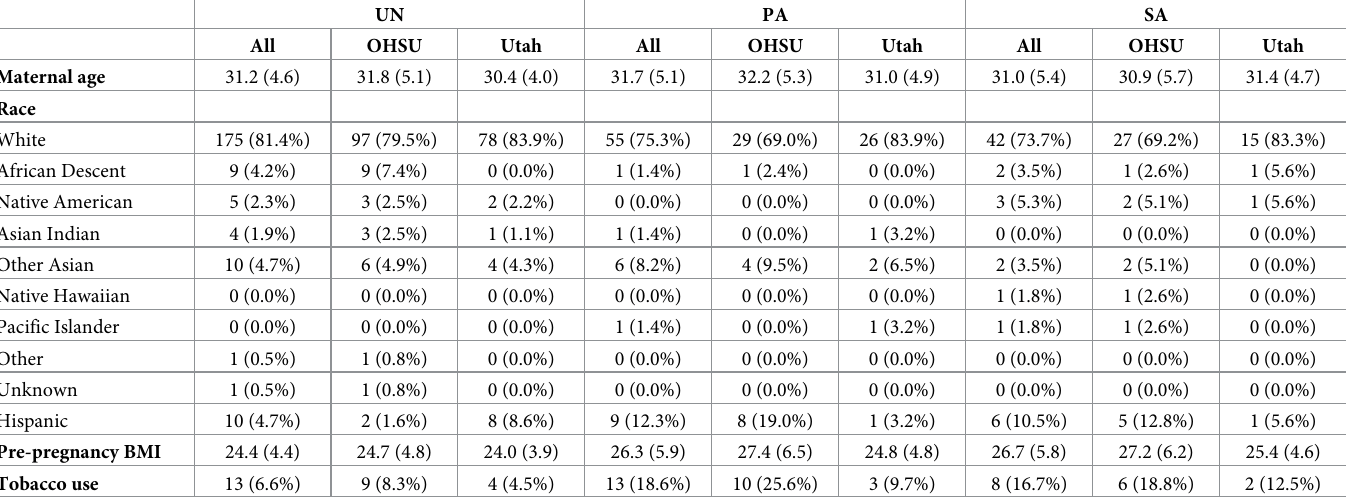
Table 1. Demographic data from the study populations at OHSU and UU. UN PA SA All